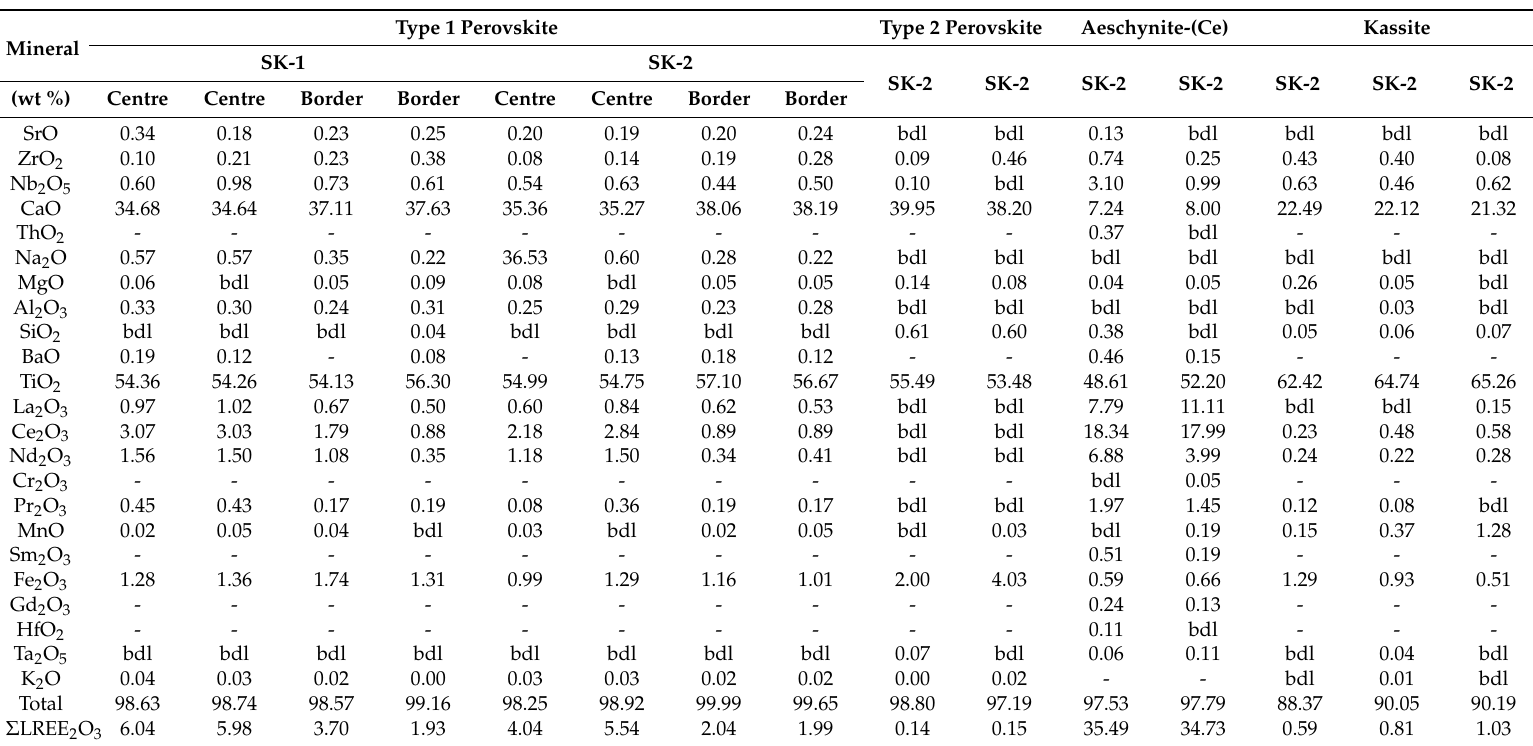
Table 1. Representative electron microprobe (EMPA) analysis of type 1 perovskite from SK-1 and SK-2 kimberlites, type 2 perovskite, aeschynite-(Ce) and kassite from SK-2